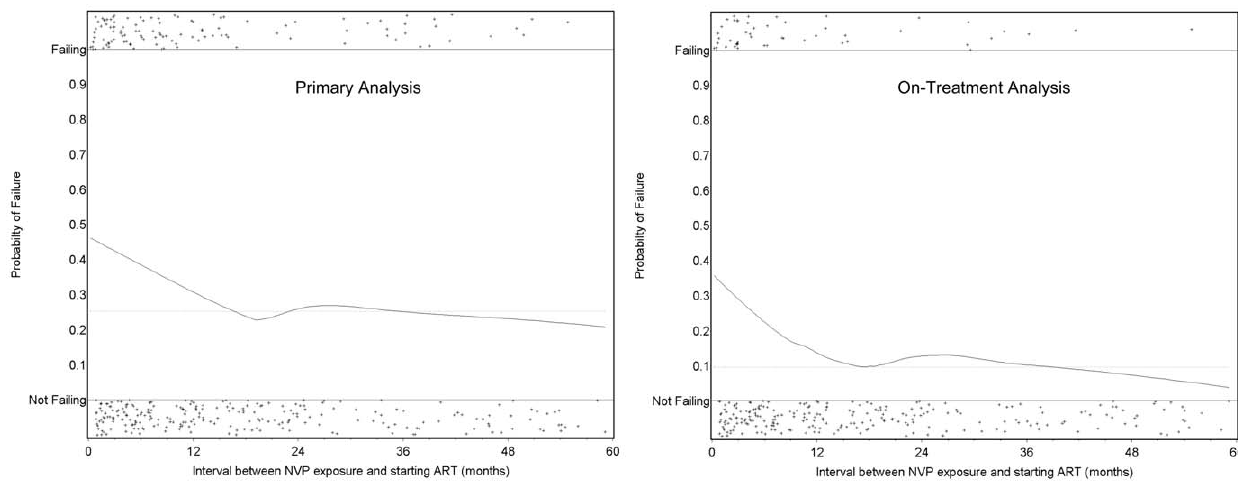
Figure 3. Time between exposure to single-dose NVP and starting antiretroviral therapy and the probability of treatment failure in the NNRTI Response Study—Zambia, Kenya, Thailand (2005–2008). Locally weighted regression (LOESS) models of the risk of treatment failure as a function of the time interval between NVP ingestion and starting ART. The left panel defines treatment failure according to the study’s primary definition; the right panel defines treatment failure according to a planned secondary definition (see Methods). The horizontal dotted line indicates the failure rate among the women who were not exposed to single-dose NVP. The individual plusses ( + ) indicated on each panel represent individual patients who were either failing (top) or not failing (bottom).